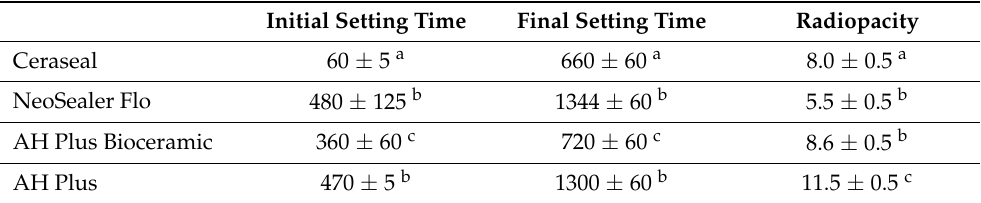
Table 1. Initial and final setting times (min, mean ± SD; n = 3) and radiopacity (mmAl, mean ± SD; n = 3). Different superscript letters (vertical row) indicate statistically significant differences ( p < 0.05) among materials.